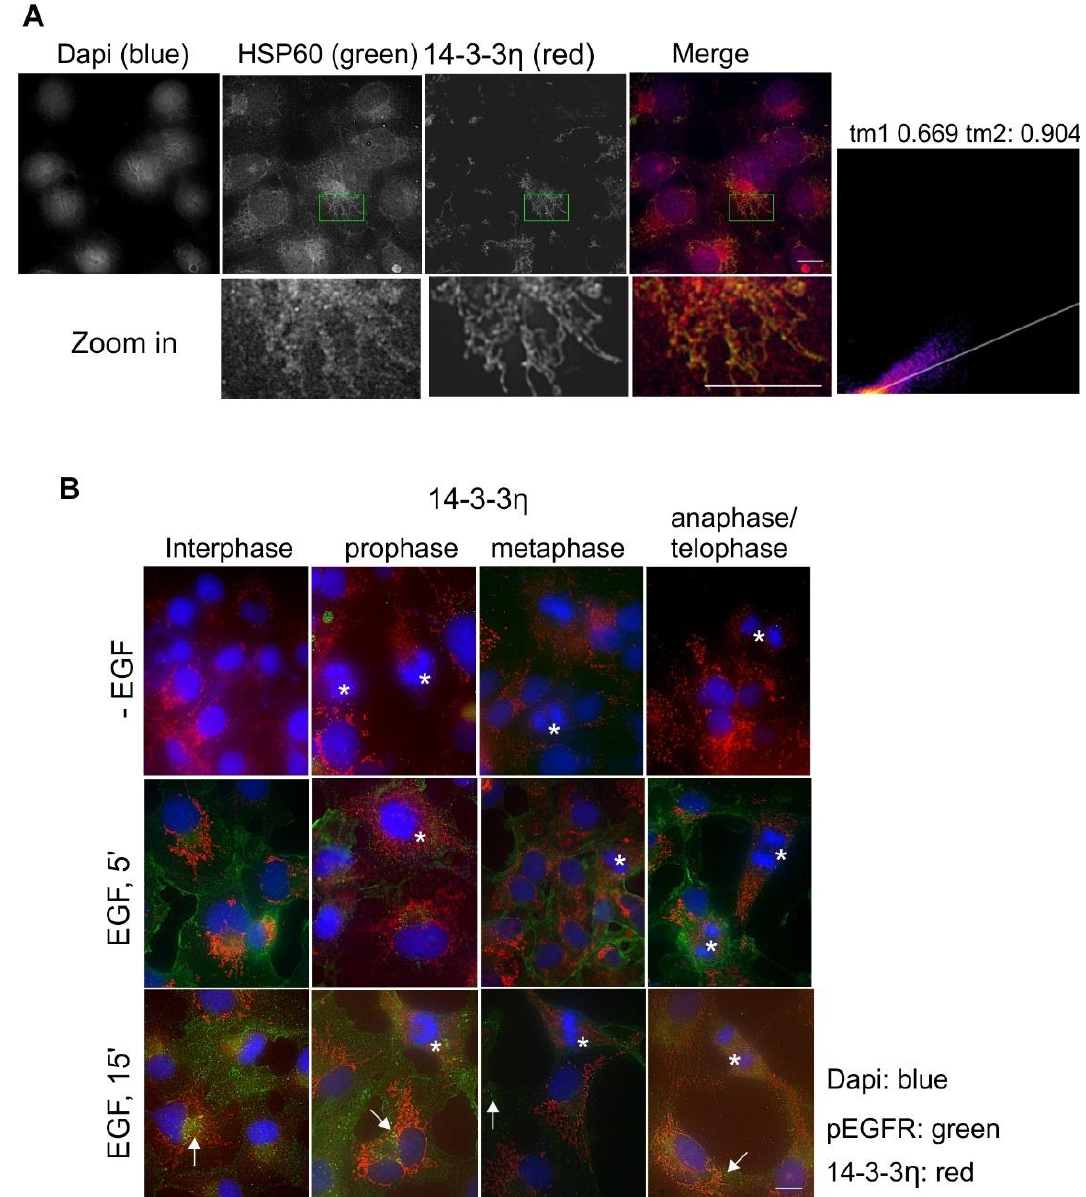
Figure 6. Subcellular localization of 14-3-3η in Cos-7 cells by double indirect immunofluorescence. ( A ) Co-localization of 14-3-3η (red) and HSP60 (green). The zoomed-in areas were used to calculate Mander’s coefficients. ( B ) Subcellular localization of 14-3-3η during the cell cycle and in response to EGF. With or without EGF stimulation, 14-3-3η (red) and pEGFR (green) were revealed by double indirect immunofluorescence. Mitotic cells are labeled by * and endosomes are marked by arrows. Scale bar = 10 μm.